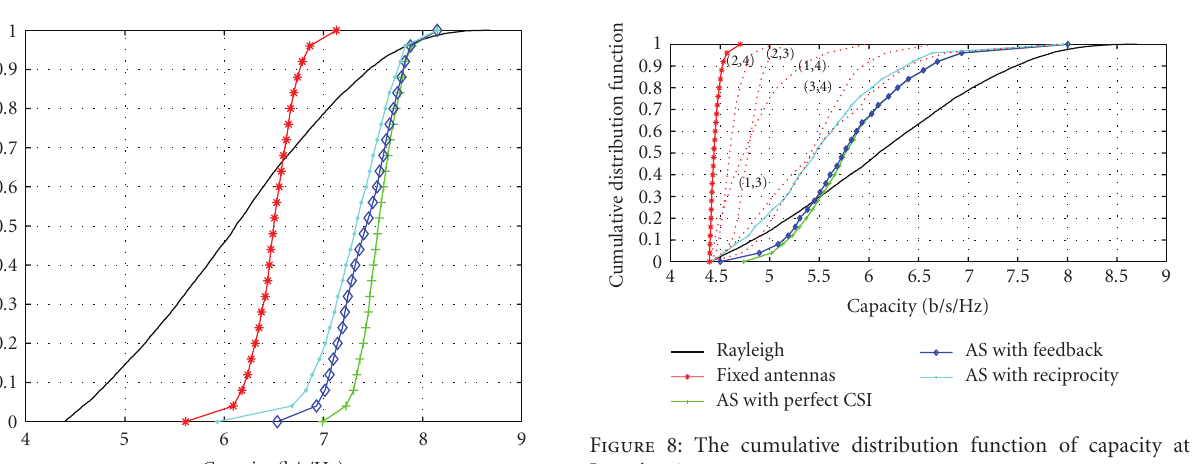
Figure 8: The cumulative distribution function of capacity at Location 3.